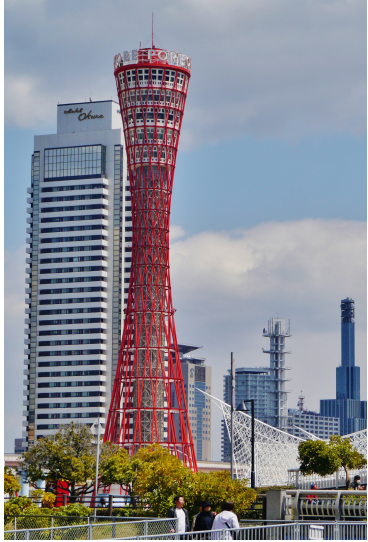
Figure 1: Kobe Port Tower in Japan (cf. [1])